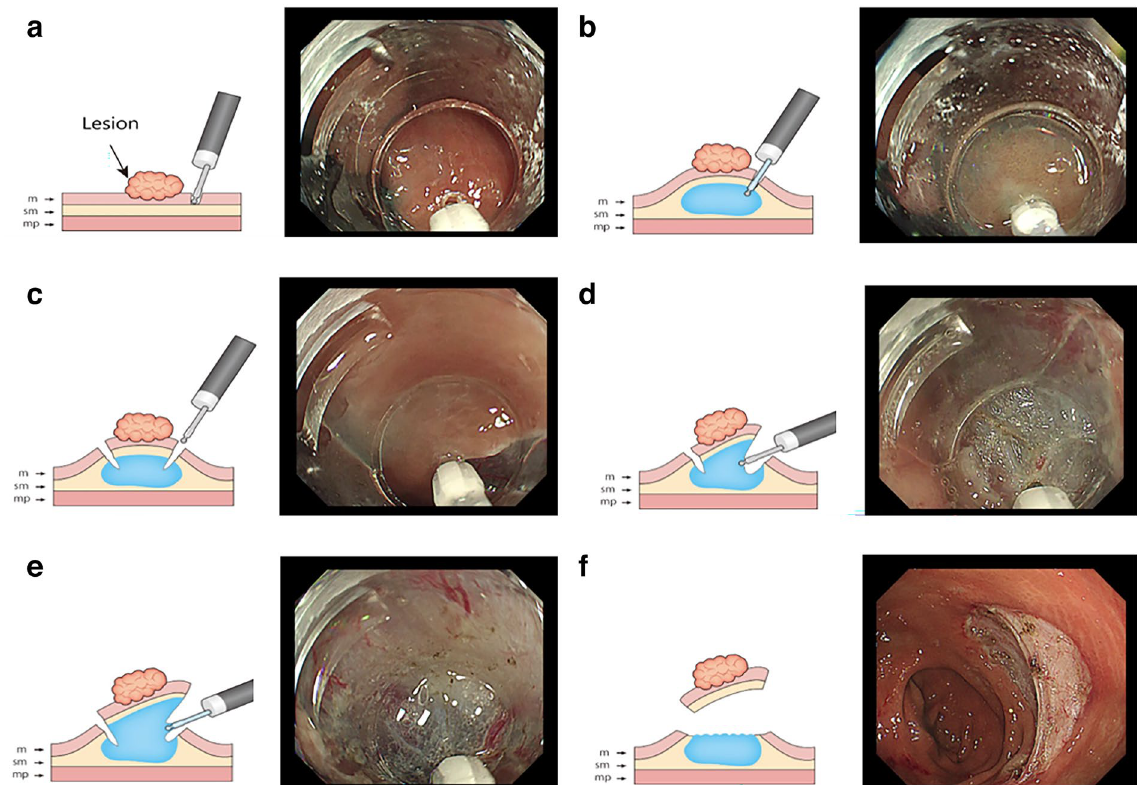
Figure 5. Diagrams and images depicting each stem of self-completion endoscopic submucosal dissection. m; mucosa, sm; submucosa, mp; muscularis propia. ( a ) Diagram and image depicting mucosal pre-cut. ( b ) Diagram and image illustrating submucosal injection. ( c ) Diagram and image of making an incision in the mucosal layer. ( d ) Diagram and image depicting the dissection of submucosal layer. ( e ) Diagram and image depicting additional injections into the submucosal layer. ( f ) Diagram and image depicting the removal of the